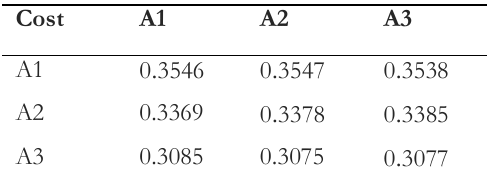
Table 7. Suppliers compared with